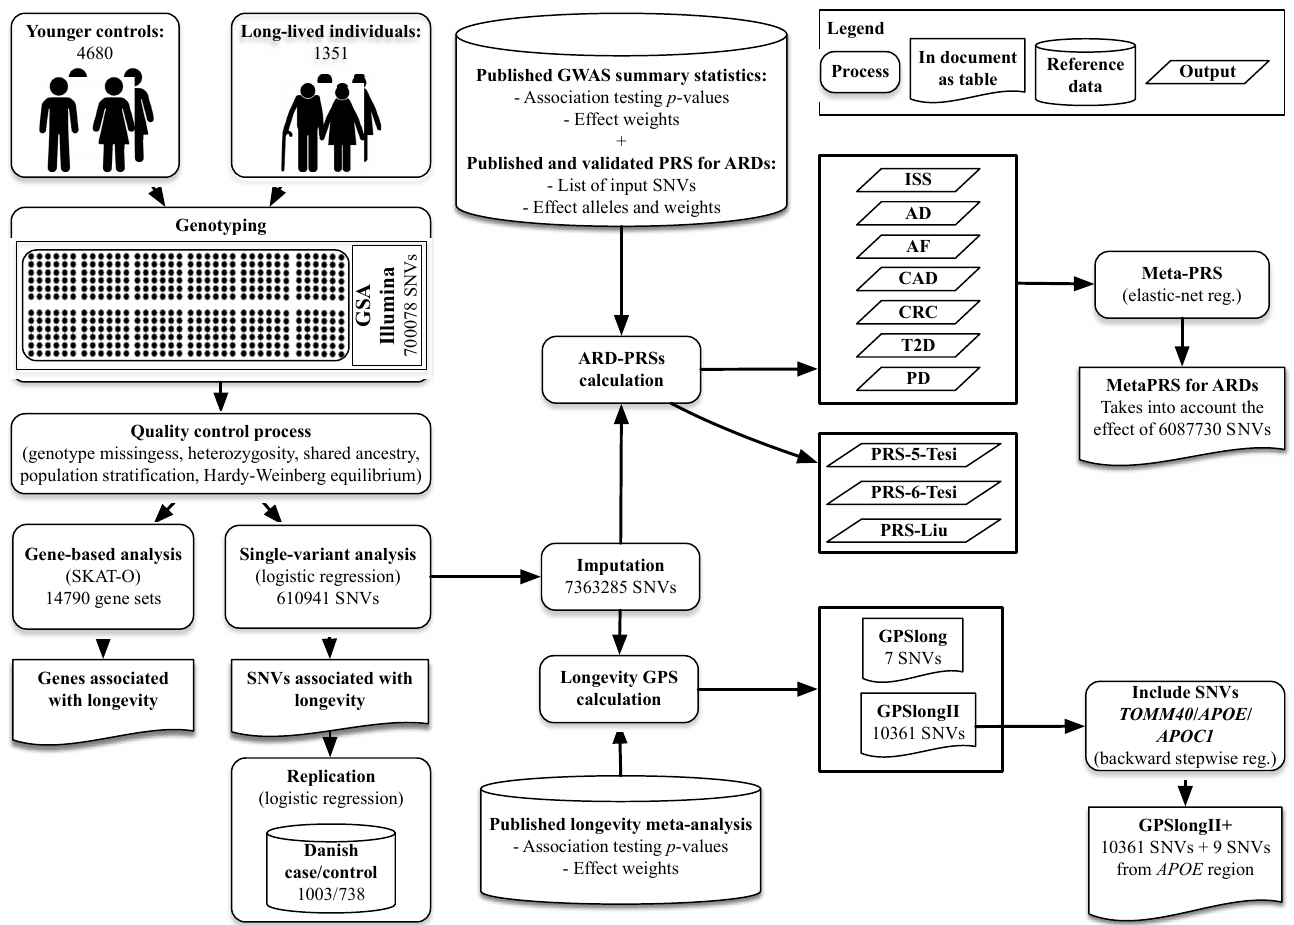
Figure 3. Study design and workflow of the longevity case–control GWAS, calculation of ARD-PRSs, meta-PRS for the diseases and the GPS for longevity. AD, Alzheimer´s disease; AF, atrial fibrillation; ARD, age-related disease; CAD, coronary artery disease; CRC, colorectal cancer; ISS, ischemic stroke; GPS, genome-wide polygenic score; GWAS, genome-wide association study; PD, Parkinson´s disease; PRS, polygenic risk score; SNV, single nucleotide variant; T2D, type 2 diabetes mellitus. The 1003 Danish cases (mean age: 97.4 years, age range: 90.0–102.5 years, 75.7%